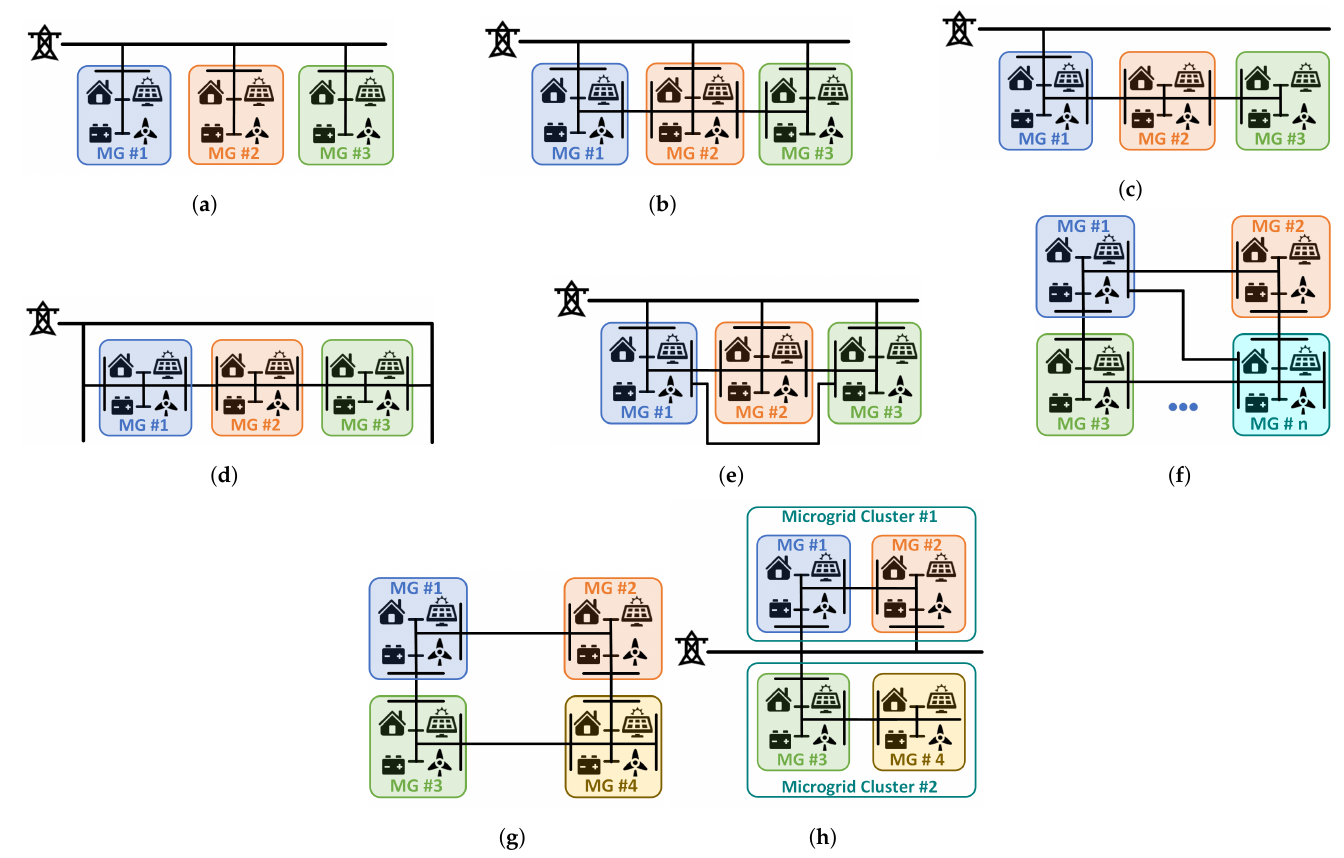
Figure 1. Different architectures of MMGs. ( a ) Radial topology [28], parallel-connected MGs with an external grid [3]. ( b ) Daisy-chain topology [28]. ( c ) Serial MGs on a single distribution feeder [4]. ( d ) Interconnected MGs on multiple distribution feeders [4] ( e ) Mesh topology [28]. ( f ) Grid series- interconnected MGs [3]. ( g ) Ring formation [3]. ( h ) Mixed parallel-series connection [3].